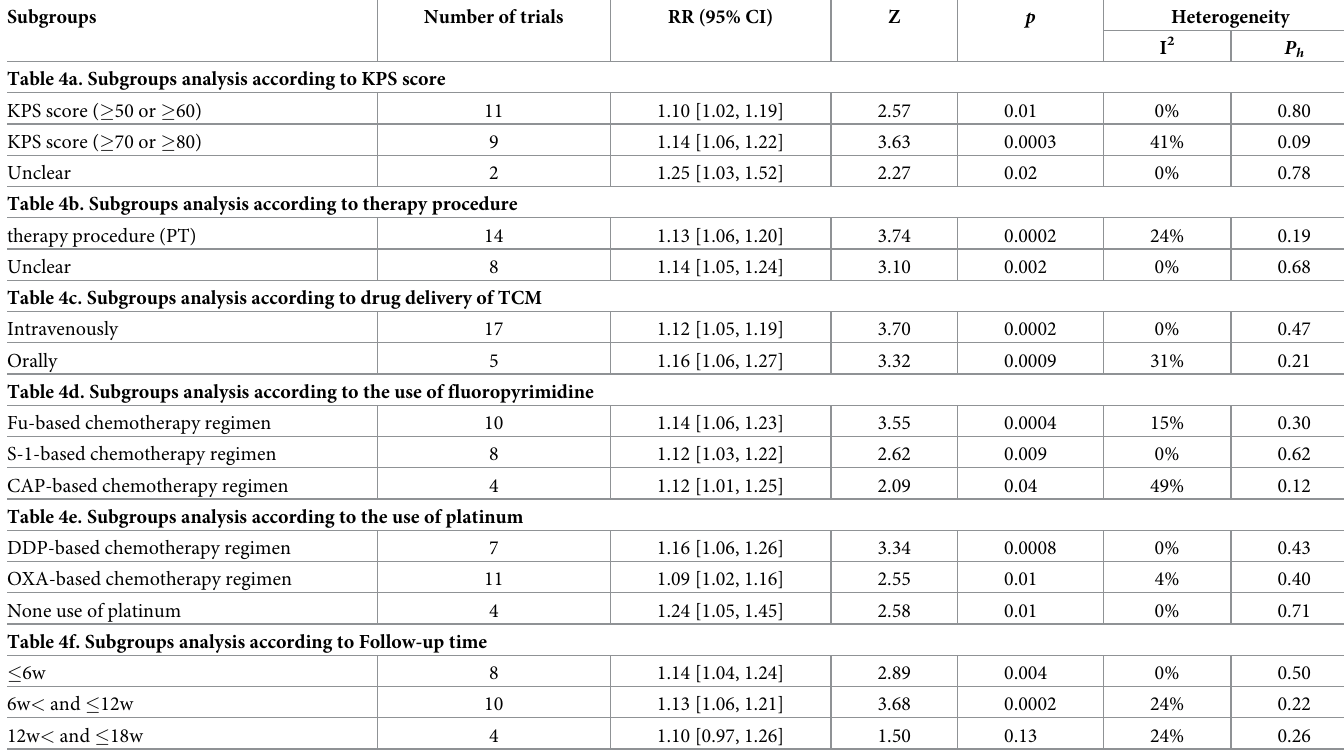
Table 4. Subgroup analysis of the DCR.